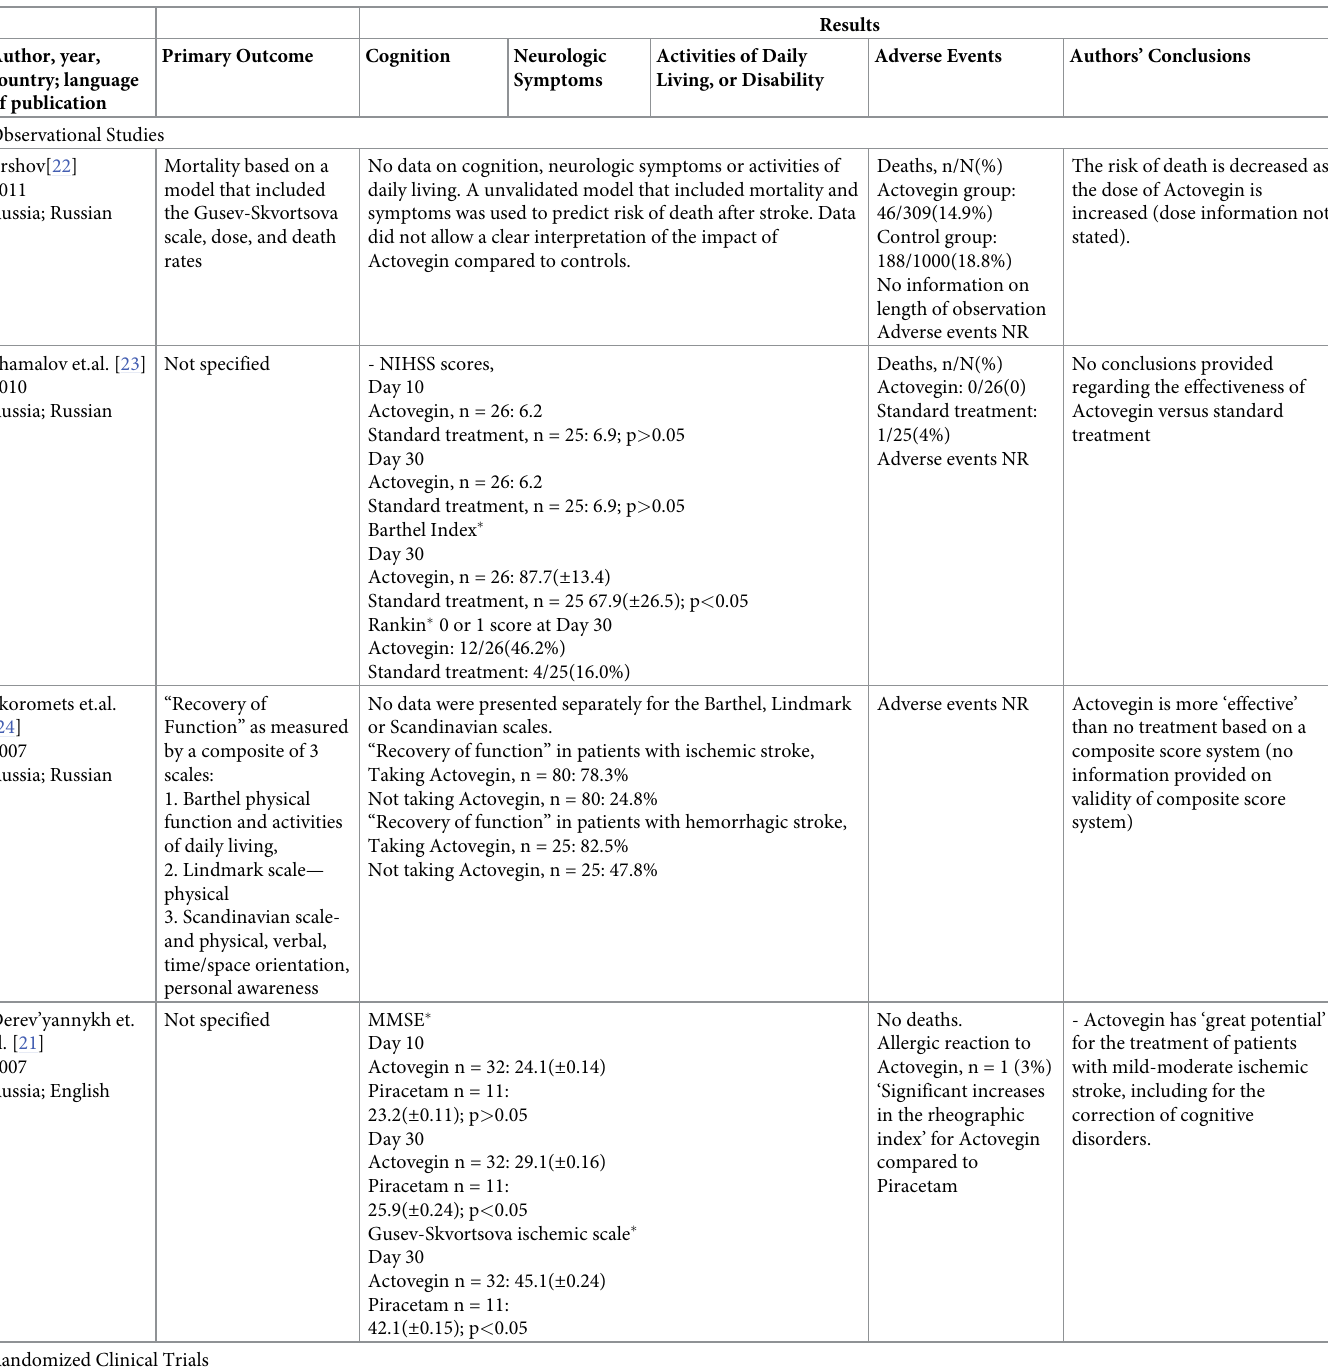
Table 2. Outcomes and results of the included